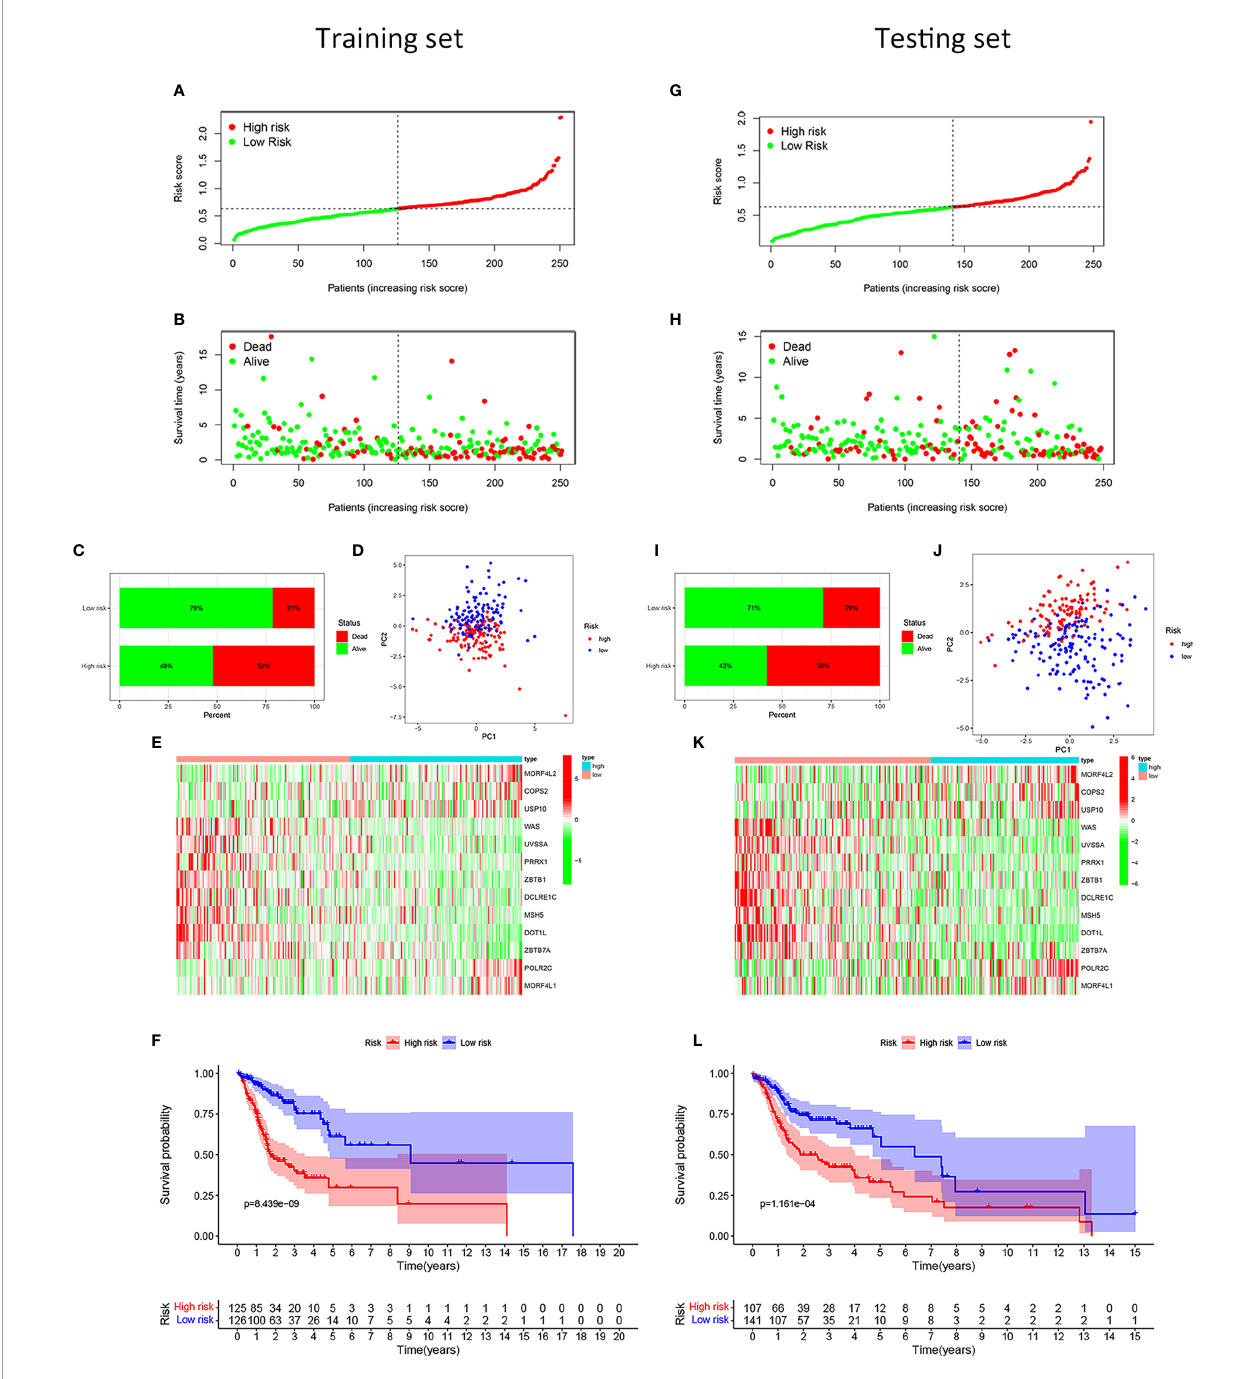
FIGURE 2 | Development and validation of the risk model for patients with HNSCC. Distribution of the HNSCC samples with different risk scores in the training set (A) . According to the median value, the HNSCC samples were divided into high- (red dot) and low-risk (green dot) groups. The distribution of survival status of HNSCC samples (B) . The red dot indicated dead status, and the green dot indicated alive status. Percentage of patients with HNSCC in alive or dead status (C) . The red bar meant dead status, and the green bar meant alive status. PCA of HNSCC samples (D) . The red dots indicated HNSCC samples in the high-risk group, while the blue dot meant low risk. Heat map depicting the expression patterns in the 13 DRGs between high- and low-risk groups (E) . Kaplan-Meier survival curve demonstrating the clinical outcome differences between high- and low-risk groups (F) . In the testing set, the distribution of the risk scores among all HNSCC samples (G) . The distribution of survival status of HNSCC samples (H) . Percentage of patients in survival status and death status (I) . PCA of HNSCC samples (J) . Heat map depicting the expression differences in the 13 DRGs between high- and low-risk groups (K) . Kaplan-Meier survival curve showing the clinical outcome differences between the two groups (L)